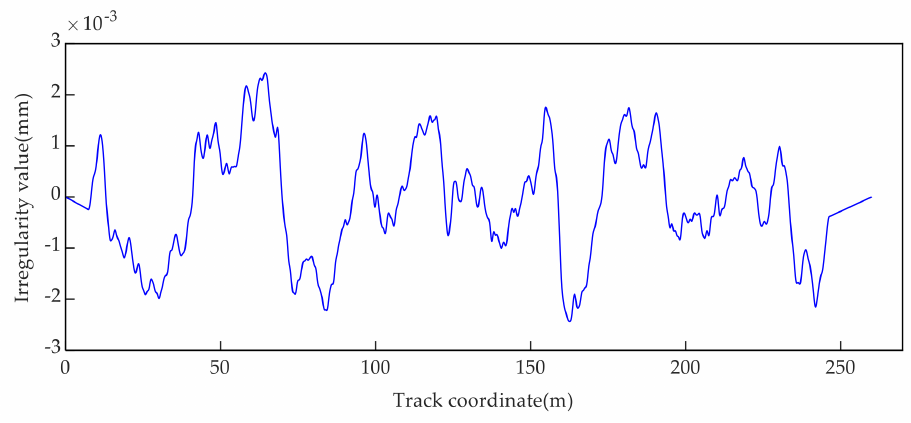
Figure 5. Sample of the medium-long wave random irregularity.